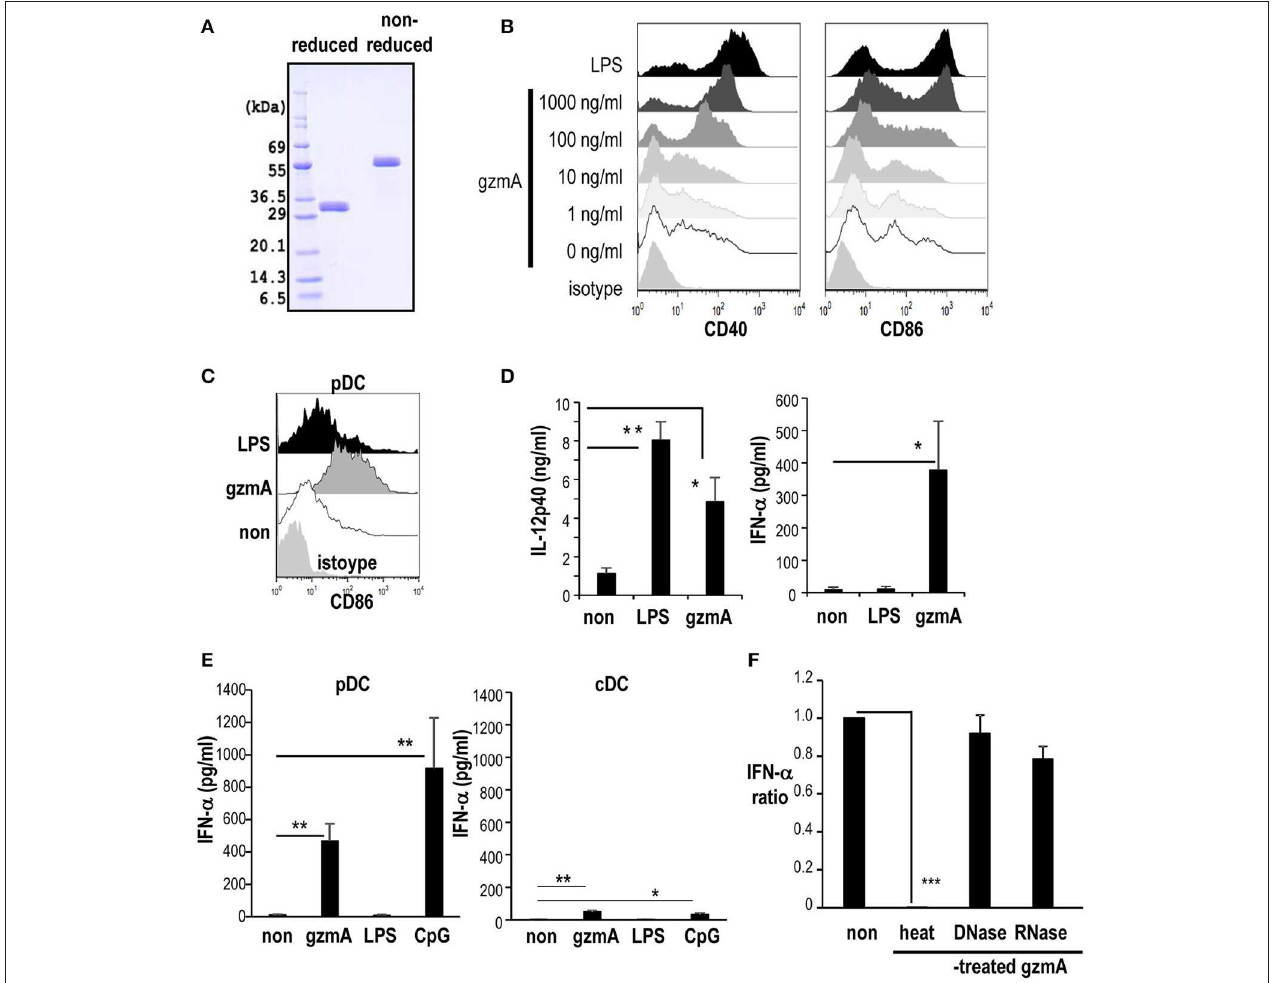
FIGURE 1 | GzmA promotes DC maturation. (A) Recombinant GzmA is predominantly dimeric. Reduced and non-reduced GzmA were run on 10–12 % SDS-PAGE and stained with Coomassie Brilliant Blue. (B) Phenotypic maturation. FL-DCs were generated from BMMNCs from C57BL/6 mice in the presence of Flt3L. The expression of costimulatory molecules (CD40 and CD86) on FL-DCs (CD11c + cells) were analyzed 24h after stimulation with graded dose of GzmA or LPS (100ng/ml) ( n = 3). (C) Expression of CD86 on the pDC (CD11c dim B220 + ) of FL-DCs after stimulation with GzmA (1 µ g/ml), LPS (100ng/ml) ( n = 5). (D) Cytokine production by FL-DCs stimulated with GzmA. FL-DCs were cultured in the presence of GzmA or LPS for 24h and the supernatants were assayed for IL-12p40 and IFN- α by ELISA (mean ± SEM, n = 5). * p < 0.05, ** p < 0.01 (Kruskal Wallis test). (E) IFN- α production by pDCs and cDCs. pDCs, and cDCs were sorted from FL-DCs and stimulated with GzmA (1 µ g/ml), LPS (100ng/ml), or CpG-ODN (1 µ g/ml) for 24h and the supernatants were assayed for IFN- α by ELISA (mean ± SEM, n = 4–6). * p < 0.05, ** p < 0.01 (Kruskal Wallis test). (F) Effect of treatment of GzmA with nucleases or heat. GzmA was pre-treated with nothing (non), DNase,